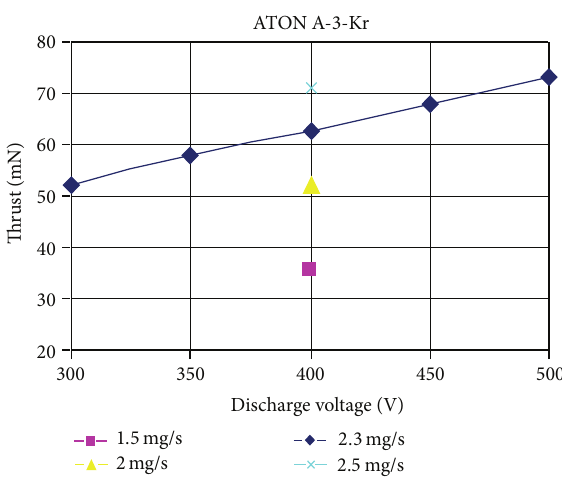
Figure 5: ATON A-3 thrust versus discharge voltage under ̇𝑚 𝑎 = 2.3 mg/s and for different Kr anode mass flow rates under 𝑈 400